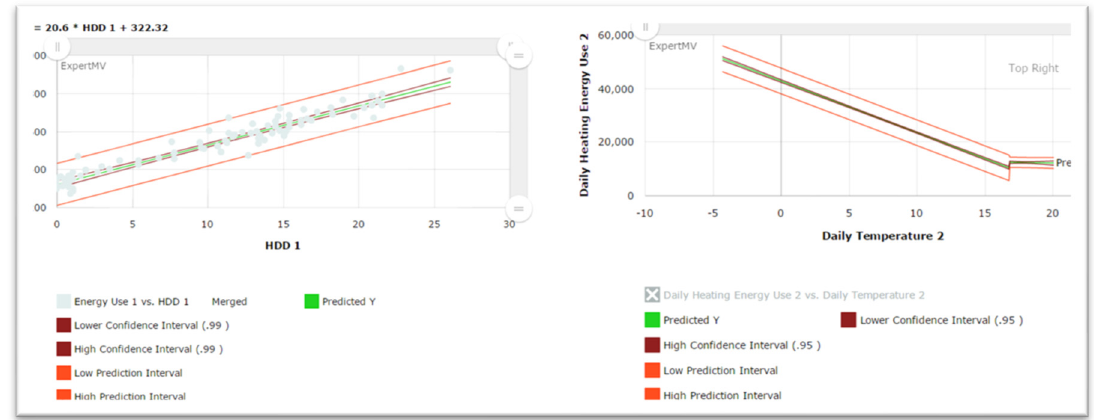
Figure 3. M&V Tool with examples of Simple Linear and Change Point Regression.